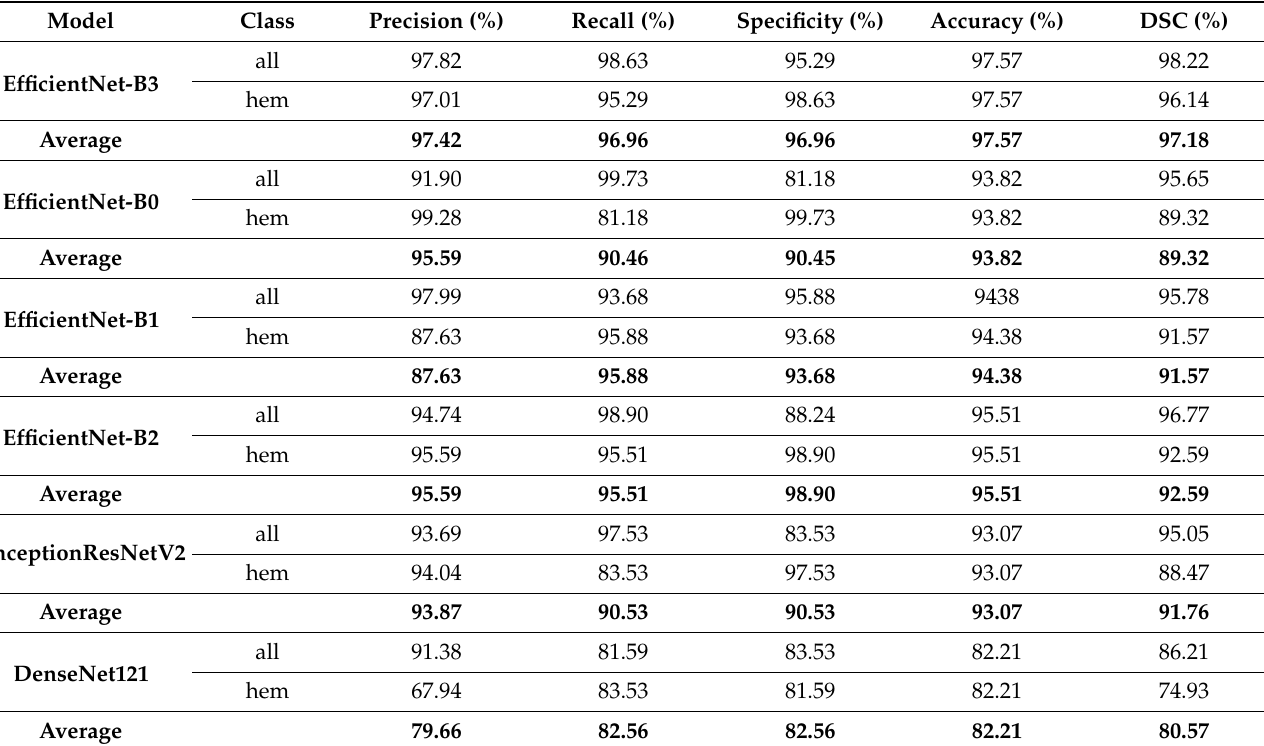
Table 2. The performance of the six CNN models using a fixed